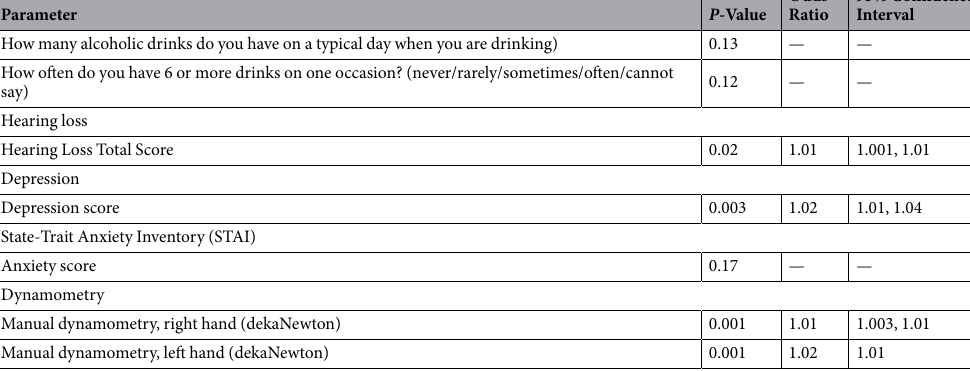
Table 3. Associations between the frequency (%) of previous bone fractures in the Ural Eye and Medical Study and other systemic parameters.